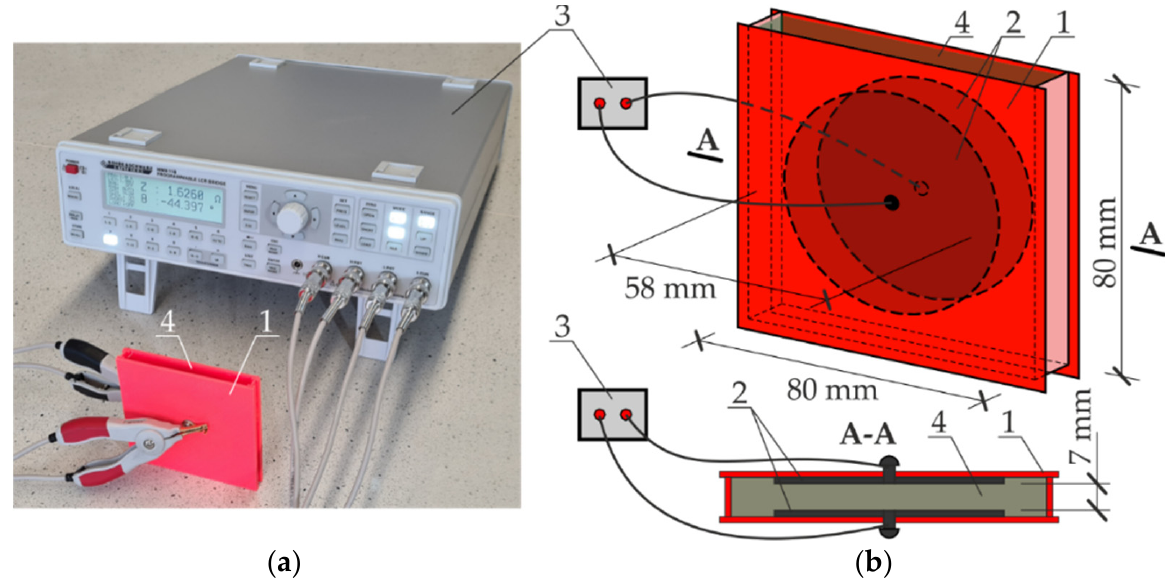
Figure 4. The test stand for measuring impedance of aqueous solution of liquid and gel electrolytes: ( a ) test stand, ( b ) design of the measuring cell. 1—measuring cell; 2—circular auxiliary electrode; 3—LCR measuring bridge; 4—liquid or gel electrolyte.